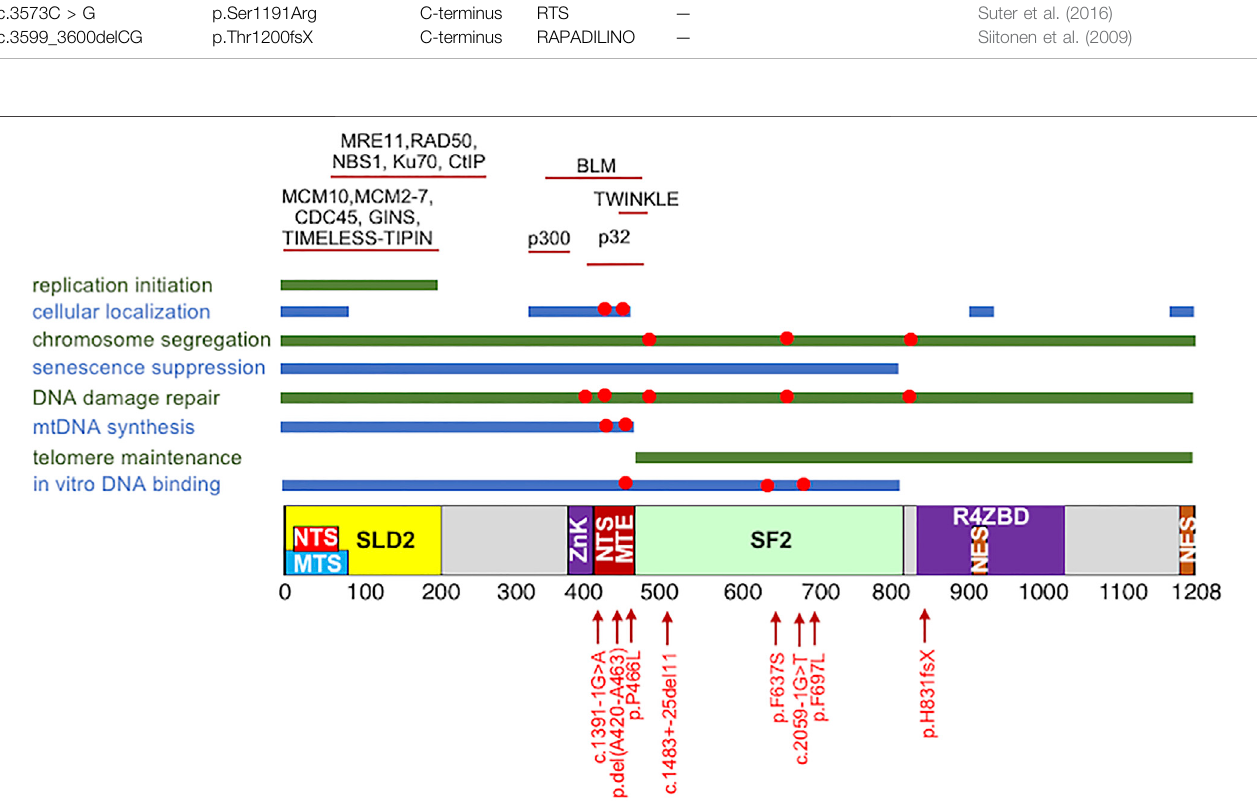
FIGURE 1 | Schematic of the human RECQ4 protein domains, including the SLD2 (yellow) and conserved SF2 helicase domains (green). NTS: nuclear targeting signal. MTS: mitochondrial targeting signal. ZnK: zinc knuckle. MTE: mitochondrial exclusion; NES: nuclear export signal. R4ZBD: RECQ4 zinc binding domain. (Top) Protein-protein interactions domains. (Middle) RECQ4 cellular functions and the domains involved. (Bottom) The disease-associated mutations that have been implicated in the RECQ4 cellular functions, as indicated with red circles in the middle.